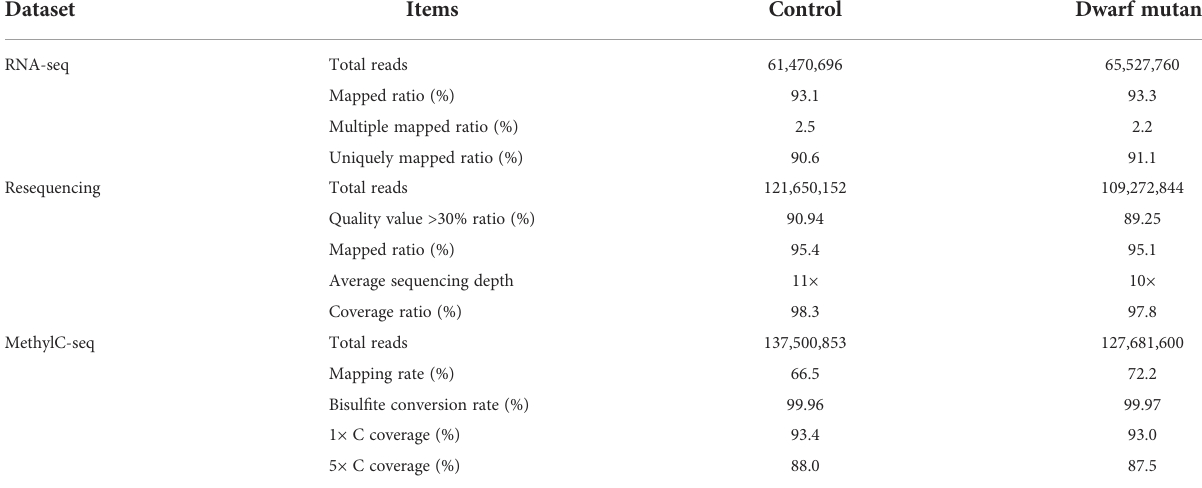
TABLE 1 Statistical summary of sequencing datasets. Dataset Items